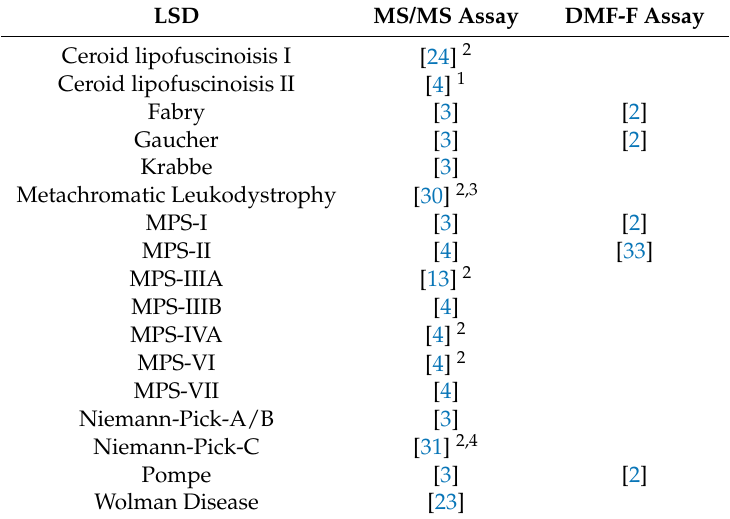
Table 4. Published newborn screening assays for LSDs using DBS 1